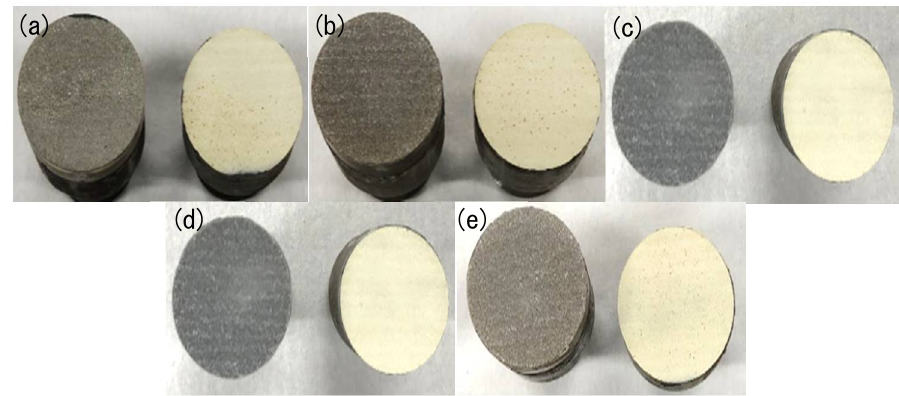
Figure 3. Fracture surface substrate and TiO 2 coating after tensile strength testing on SUS 304. ( a ) Room temperature; ( b ) annealed at 300 ◦ C; ( c ) annealed at 500 ◦ C; ( d ) annealed at 700 ◦ C; and ( e ) annealed at 1000 ◦ C.